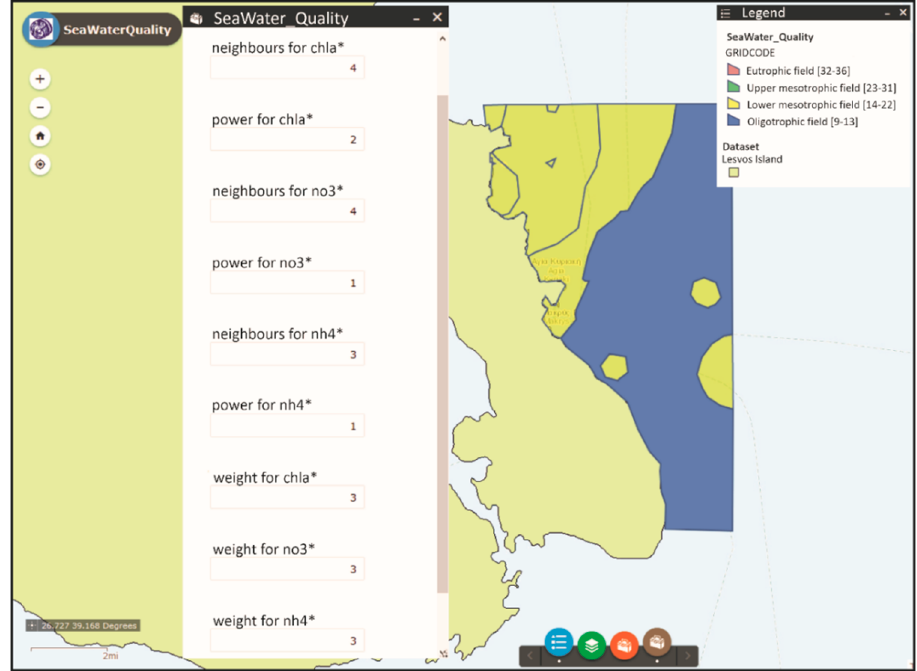
Figure 4. Spatial distribution of the eutrophication levels in the Strait of Mytilene when equal weights were assigned to all variables (The * indicates that these fields must be filled in by the user).